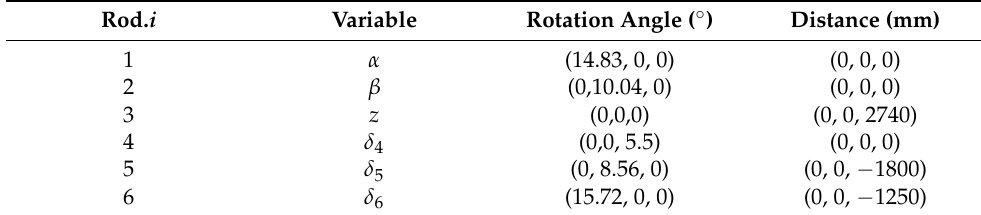
Table 2. HKM modified DH parameters. Rod.